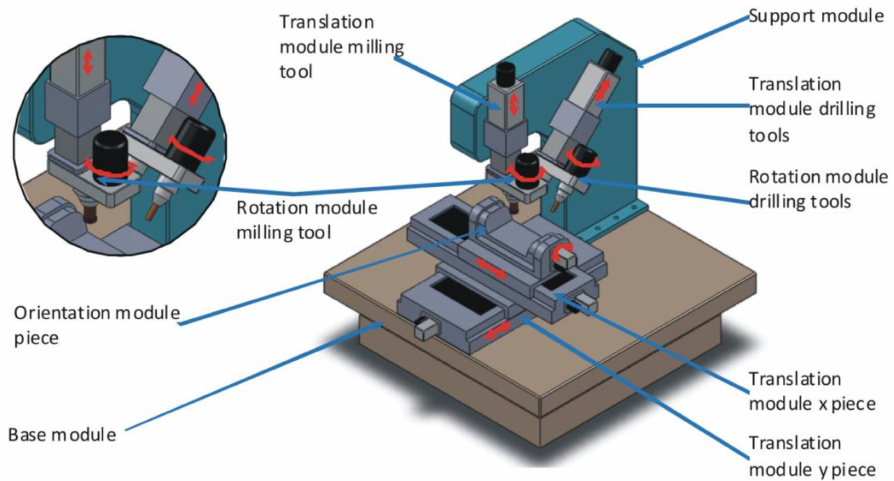
Figure 11. Particle 3 at iteration 4: variant 9.